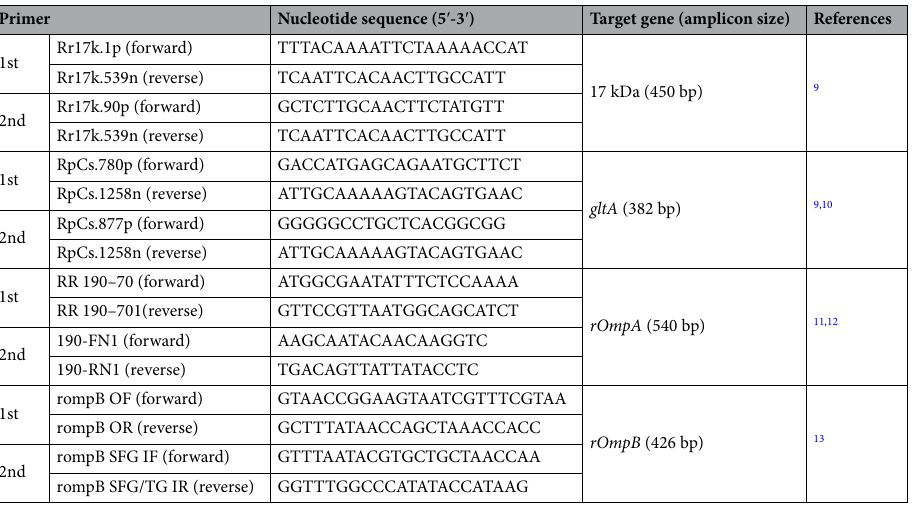
Table 2. Primer pairs used for SFGR detection and typing.